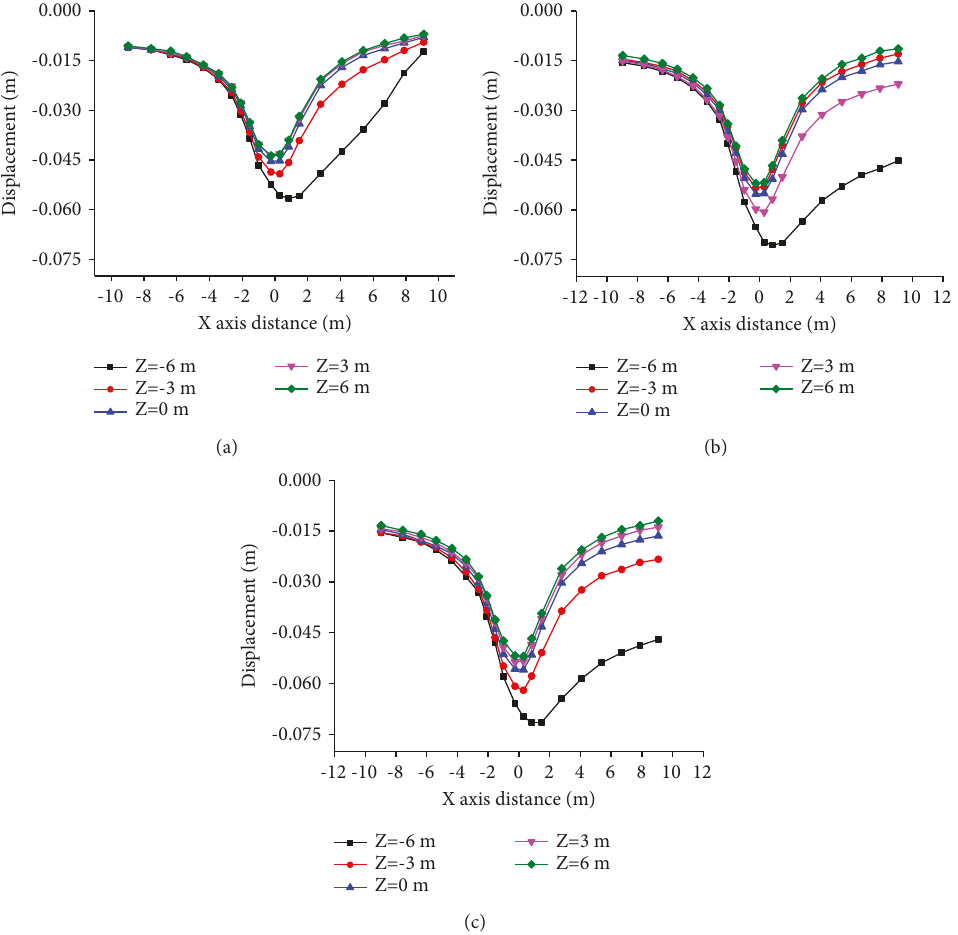
Figure 5: Vertical displacements of the roof at the monitoring sections under different distances. (a) Excavation 5m. (b) Excavation 20m. (c) Excavation